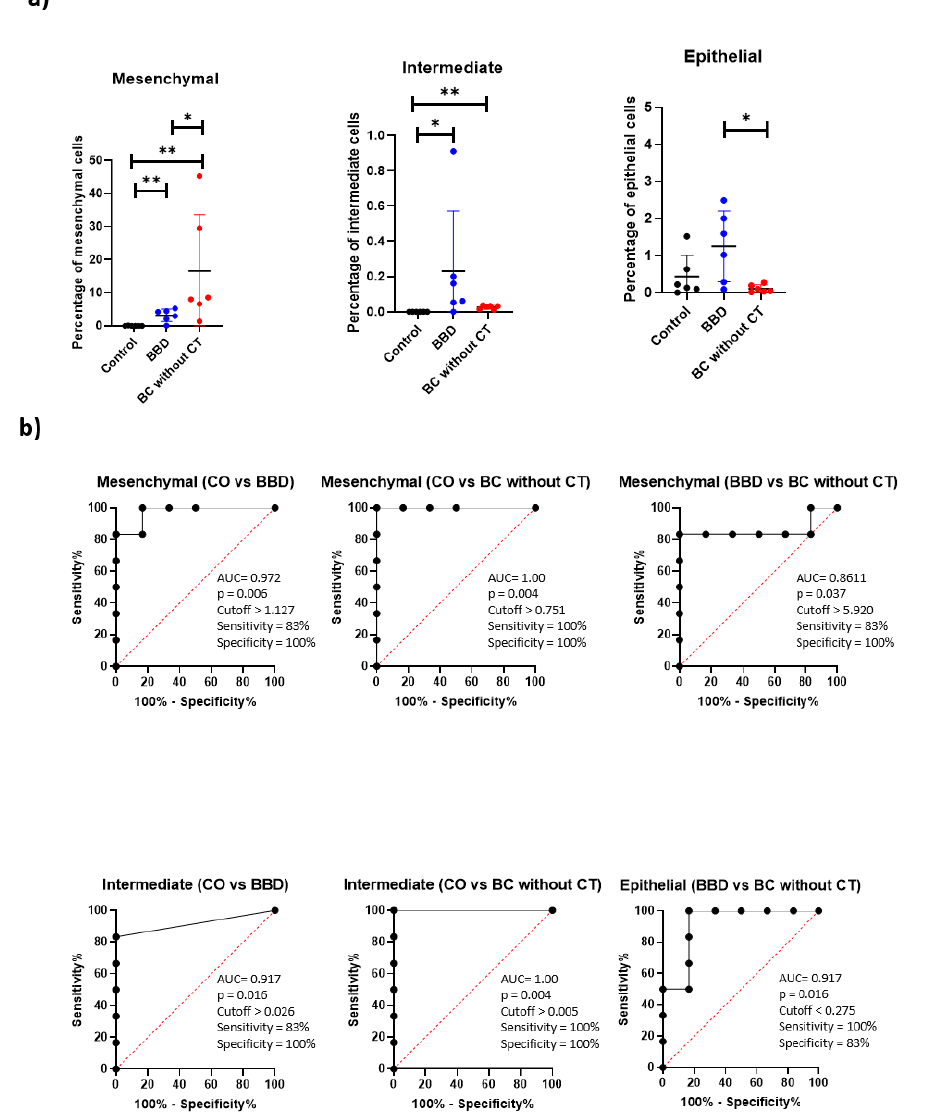
Figure 2. Diagnostic panel. ( a ) Scatter plot of percentage of mesenchymal CTCs (CD45- epithelial 6- mesenchymal 6+ mesenchymal 2+), intermediate CTCs (CD45- epithelial 6+ mesenchymal 6+ mes- enchymal 2+), and epithelial CTCs (CD45- epithelial 6+ mesenchymal 6- mesenchymal 2-) for the control group (black), benign breast disease (blue), and breast cancer without treatment (red). The line represents the median, and the error bars (whiskers) represent the percentiles (* p < 0.05, ** p < 0.005, comparison of groups via the Mann–Whitney test). ( b ) ROC curves made from the percentage mesenchymal CTCs, intermediate CTCs, and epithelial CTCs for control vs. BBD, control vs. BC without CT, and breast benign disease vs. BC without CT. Results of the area under the curve (AUC), p value, cutoff, sensitivity, and specificity are shown near the ROC